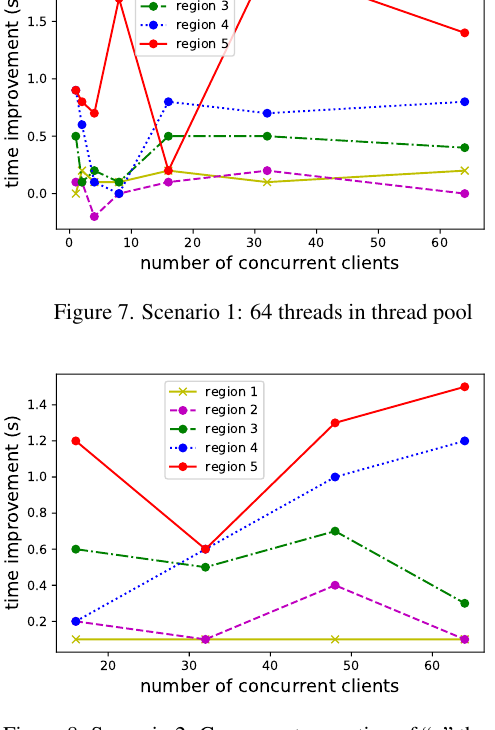
Figure 8. Scenario 2: Concurrent execution of “x” threads and “x”